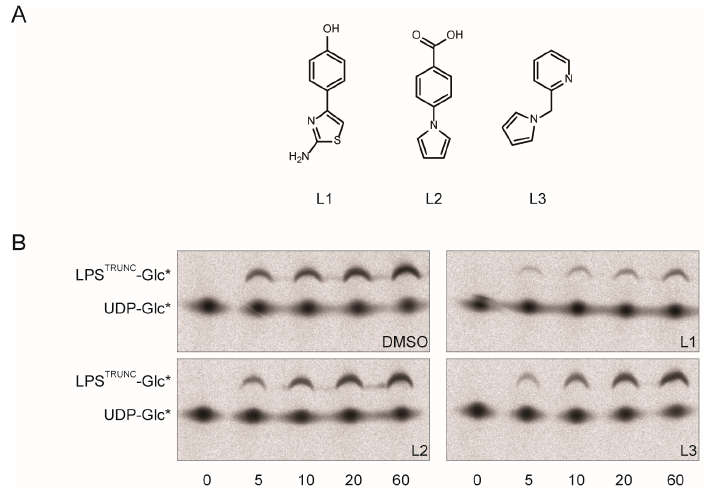
Figure 3. Cont. Figure 3.